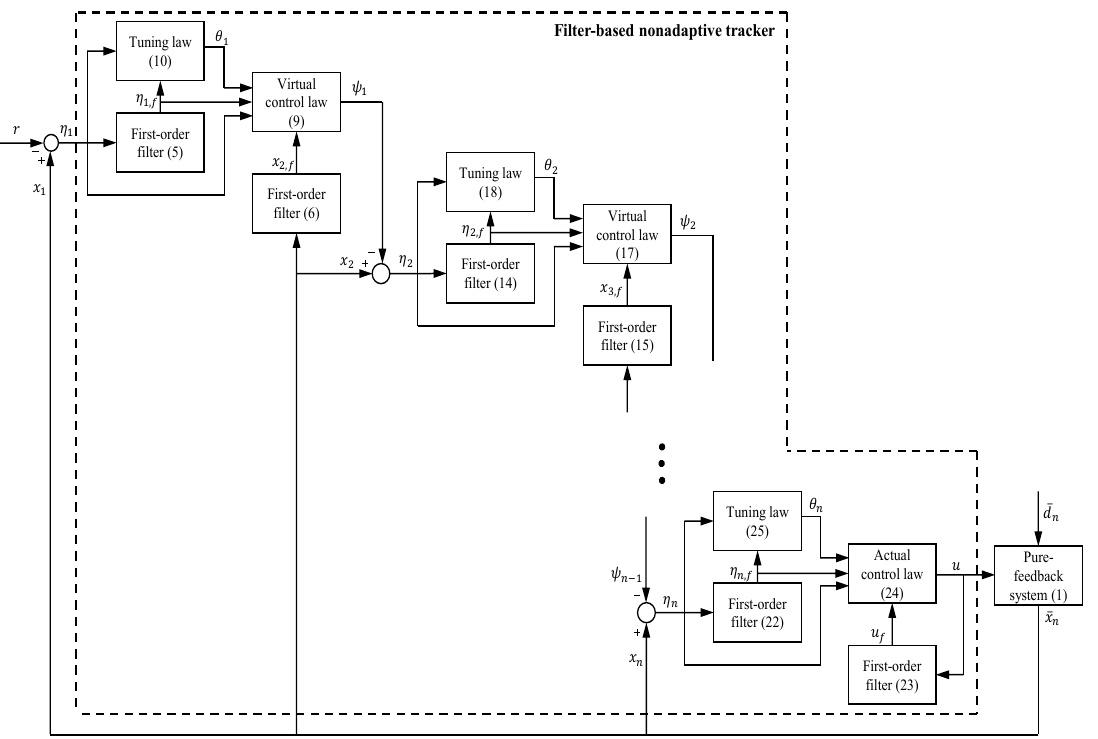
Figure 1. Block diagram of the proposed filter-based nonadaptive tracking